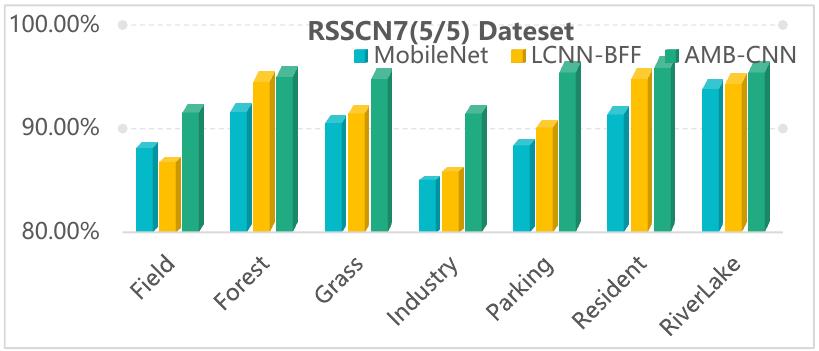
Figure 8. Average precision (AP) comparison results of the three methods for each category of the RSSCN7 (5/5) dataset.